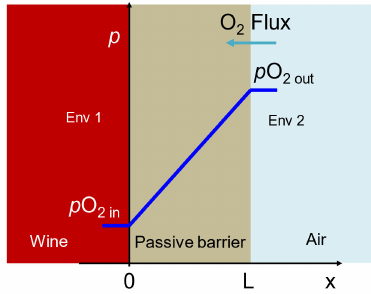
Figure 2. Diffusion scenario in a wine